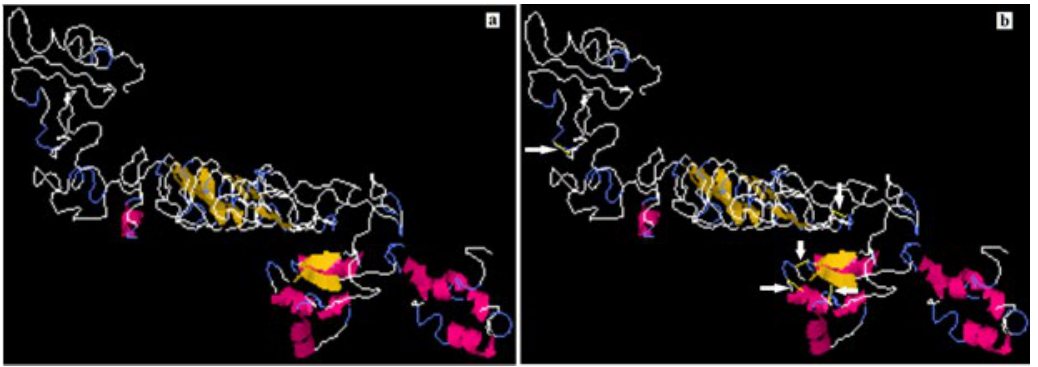
Fig. 7. Stability of the vaccine construct by disulfide bond engineering (a) the original form and (b) the mutant form. Five disulfide bonds were strongly implicated in disulfide bond formation and shown in golden sticky forms indicated by white arrows in the mutant